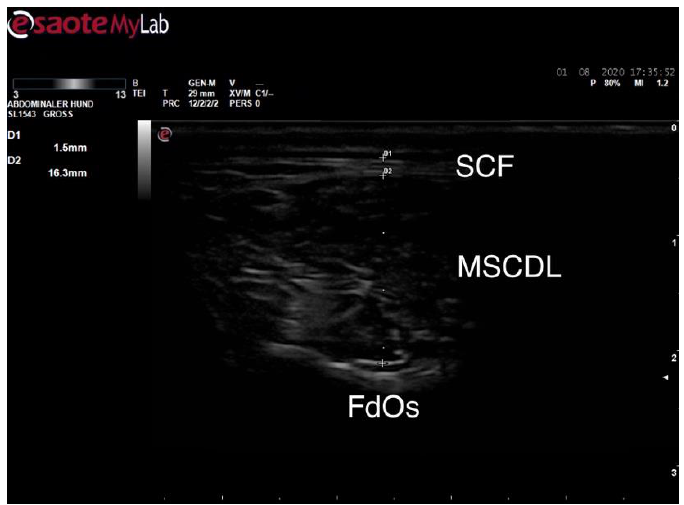
Figure 2. Sonographic documentation of the thickness of the subcutaneous fat tissue (SCF, D1) and Musculus sacrocaudalis dorsalis lateralis (MSCDL, D2), FdOs: Facies dorsalis of the Os sacrum.